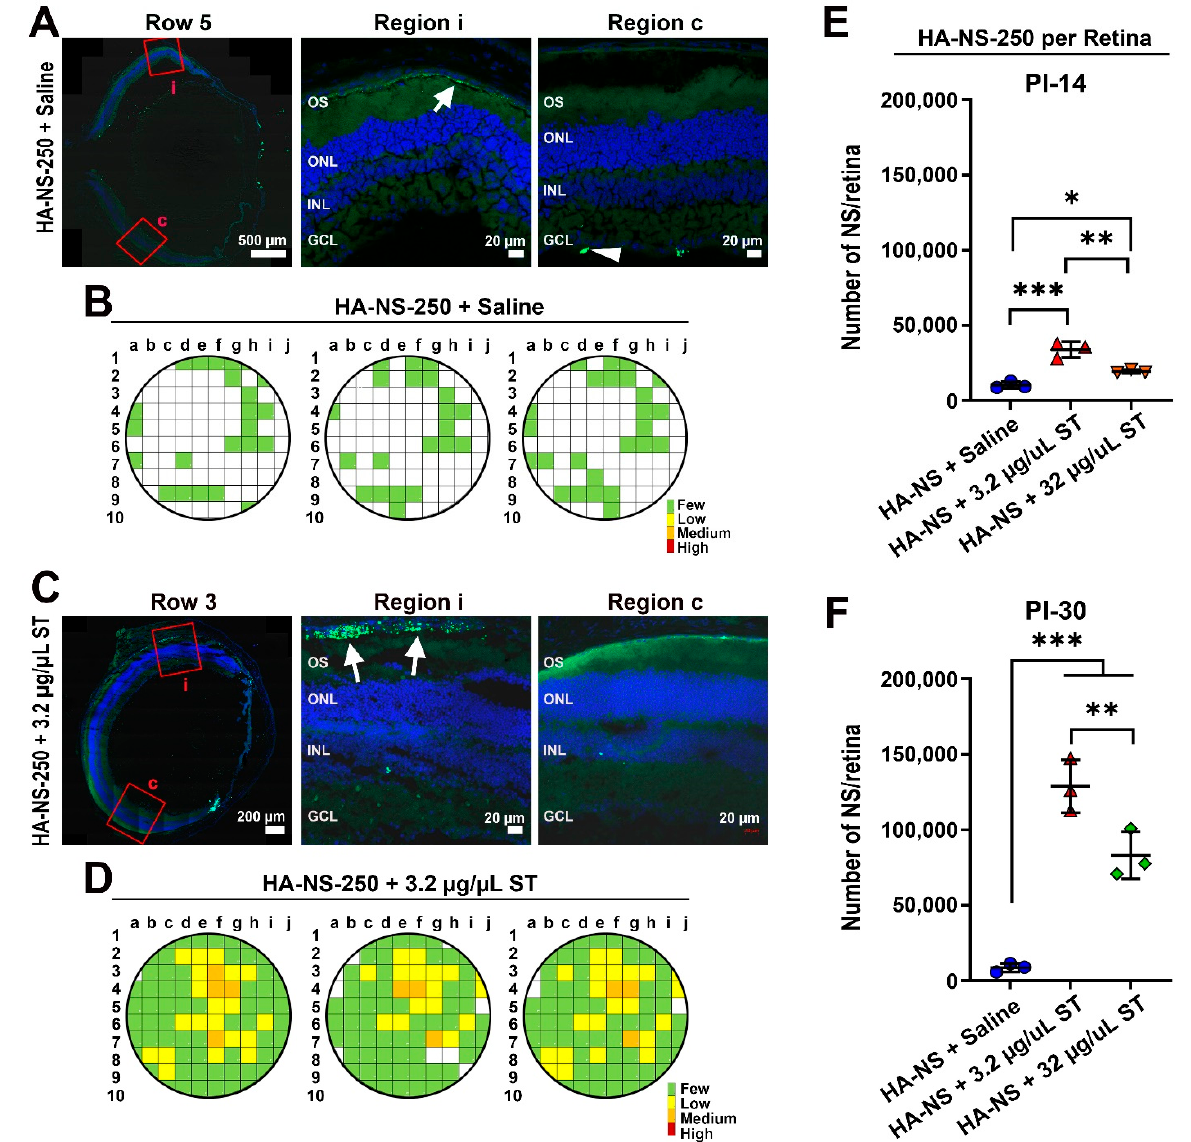
Figure 9. Co-injection of ST with HA-NS-250 leads to improved nanosphere uptake into the retina at PI-30 days. Adult mouse eyes were co-injected with 1.5 µL (5.8 × 10 6 particles/µL) HA-NS-250 and either 1.5 µL saline (vehicle, ( A , B )) or ST adjusted to a final concentration of 3.2 µg/µL ( C , D ). Tissues were collected at PI-30 days and sectioned as in Figure 2A, C . Shown are representative retinal cross sections (left) with red boxed regions shown on the middle and right. White arrows show accumulation of HA-NS-250 in the retina. ( B,D ) HA-NS-250 were counted in adjacent regions throughout a retinal section and in multiple sections throughout the eye. Each row corresponds to a section, and each box corresponds to a region in that section. Shown are maps from three different eyes. White squares contained fewer than 10, green squares contained 10–199, yellow squares contained 200–499, orange squares 500–999, and red squares ≥ 1000 HA-NS-250 puncta. ( E , F ) Total HA-NS-250 per retina at PI-14 and PI-30 days is plotted. * p < 0.05, ** p < 0.01, and *** p < 0.001 by one-way ANOVA with Tukey’s post hoc test. OS: outer segments, ONL: outer nuclear layer, INL: inner nuclear layer, and GCL: ganglion cell layer, Scale bars: 500 µm and 20 µm. n = 3 eyes per group.